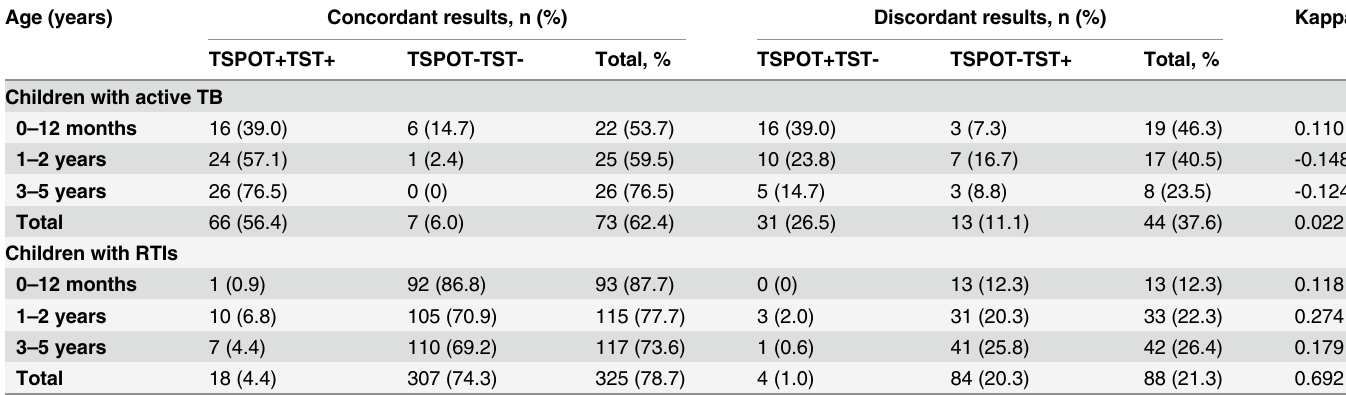
Table 4. Concordance between T-SPOT.TB and TST (10mm cut-off) for children of different ages.